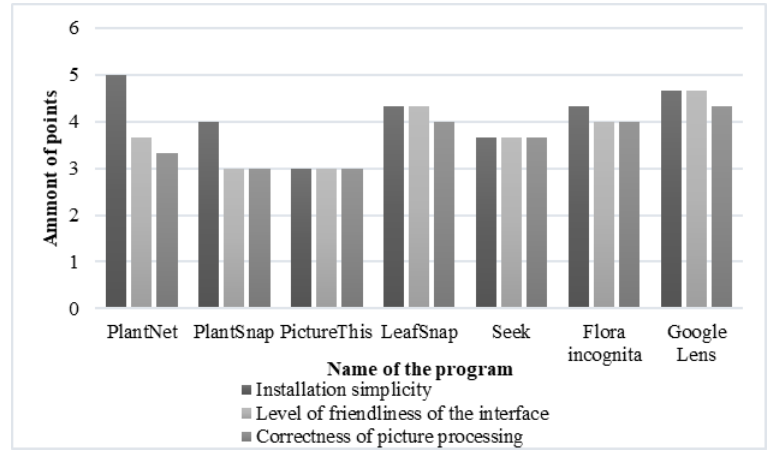
Figure 7: Results of detailed results on plants identification applications usability analysis.